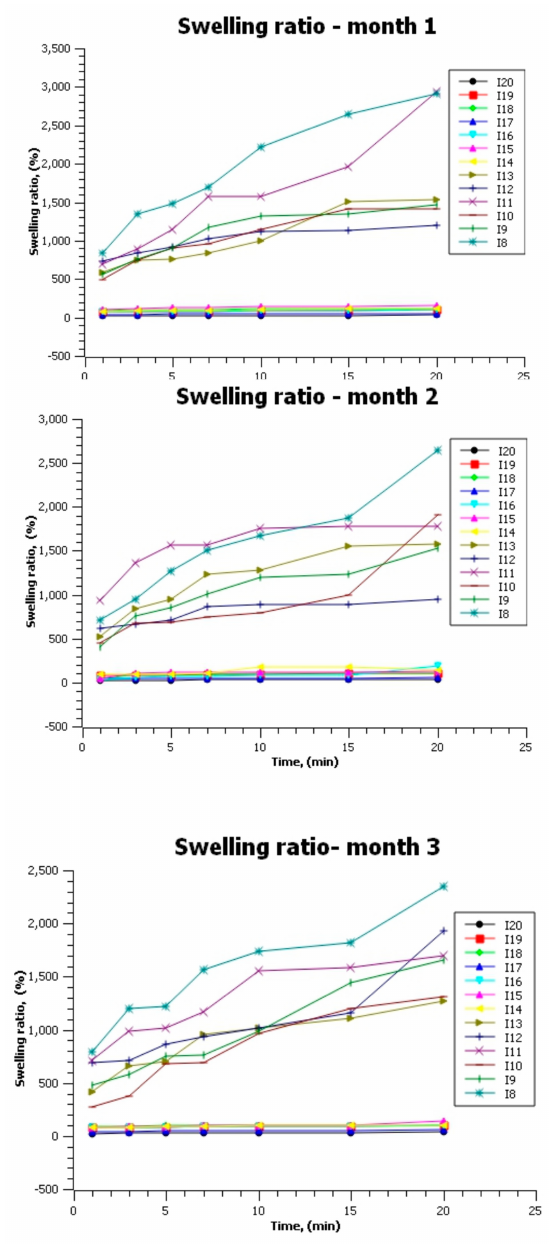
Figure 8. The graphical representation of the swelling ratio index over the three months of testing